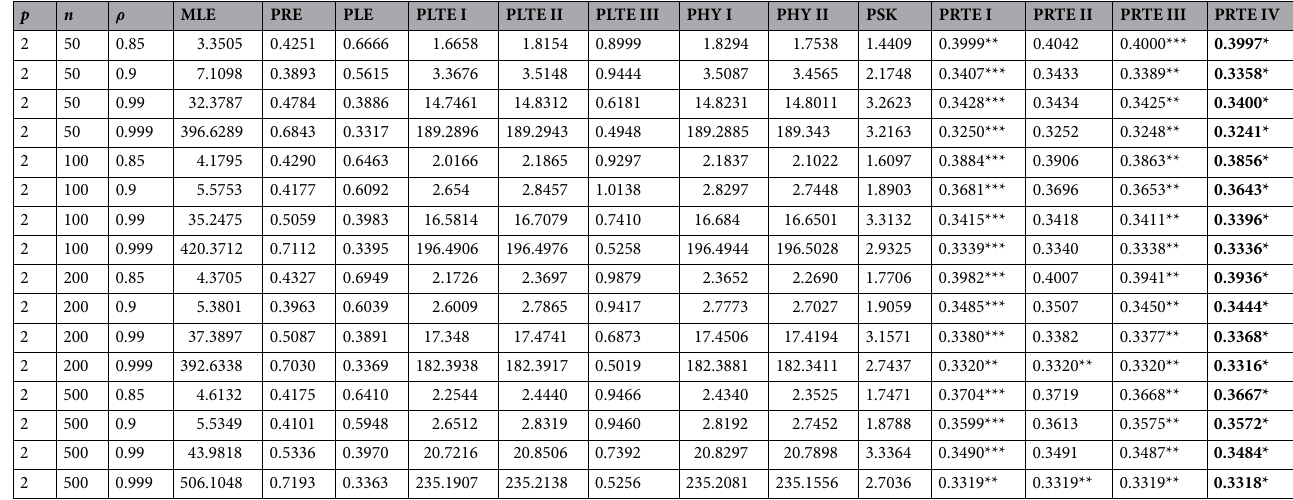
Table 1. The EMSE values of the estimators when p = 2.